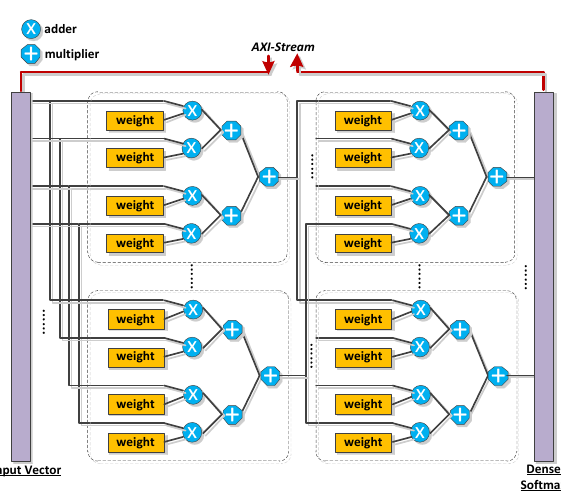
Figure 8. Structure of automatic signal modulation recognition (AMR) IP implemented using an RFNoC framework.